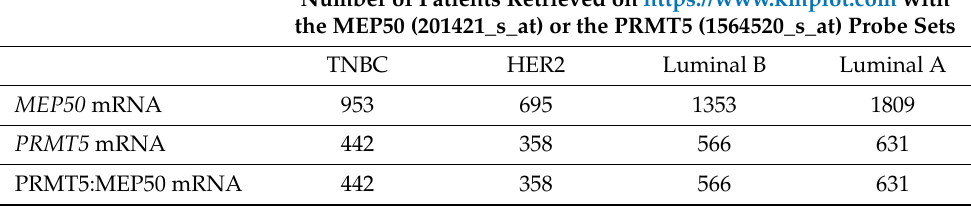
Table 4. Survival analyses in TNBC subtypes (Figure 3). Number of Patients Retrieved on https://www.kmplot.com with the MEP50 (201421_s_at) or the PRMT5 (1564520_s_at) Probe